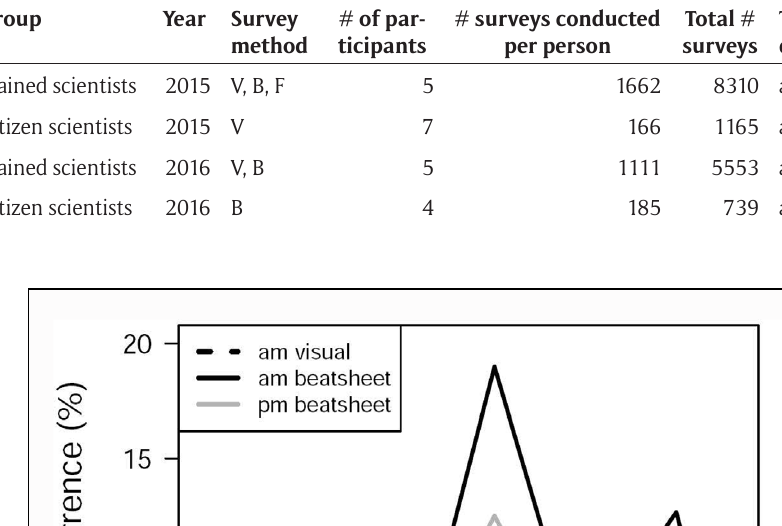
Table 2: Number of participants and number of surveys conducted from May through July for each data collection group and year. Survey method abbreviations: V, visual survey; B, beat sheet survey; F, frass monitoring.